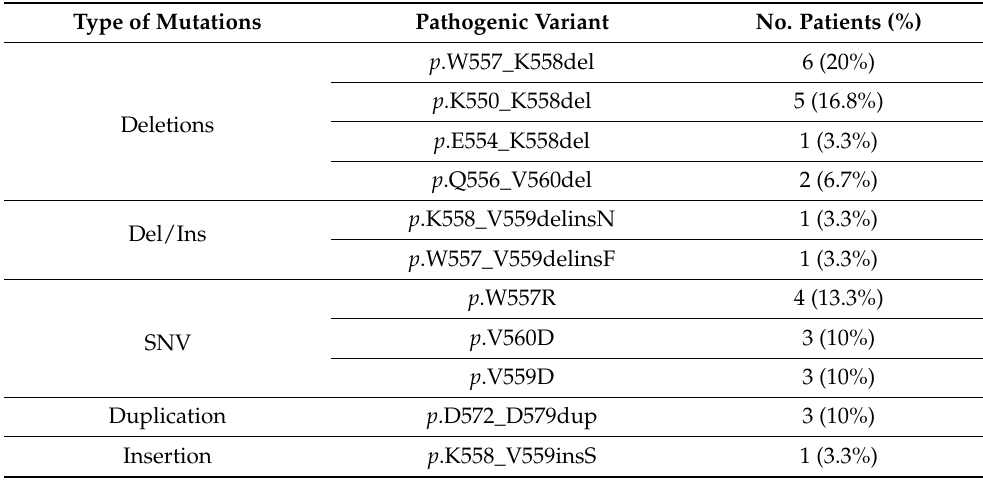
Table 2. KIT exon 11 mutations detected in mGIST patients.